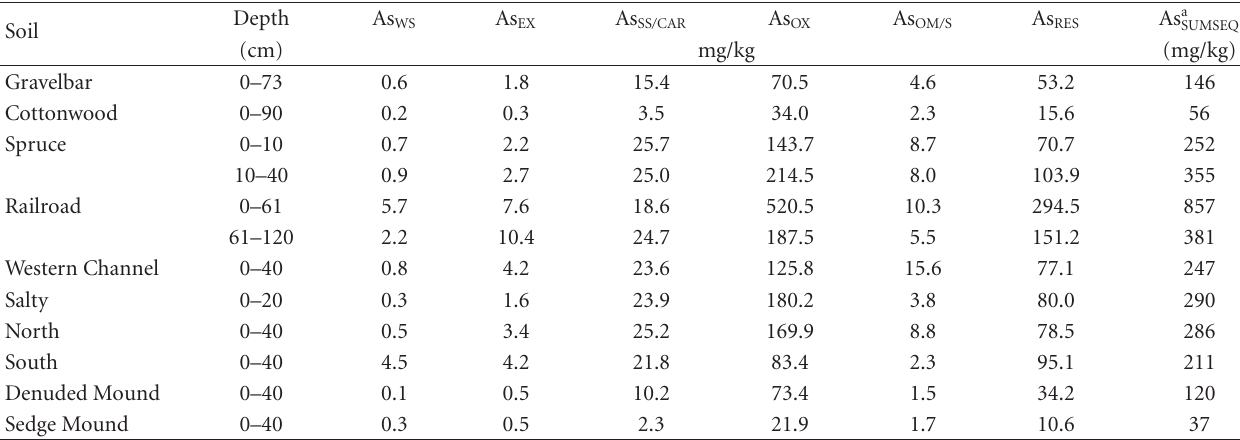
Table 14: Sequential fractionation of As in study